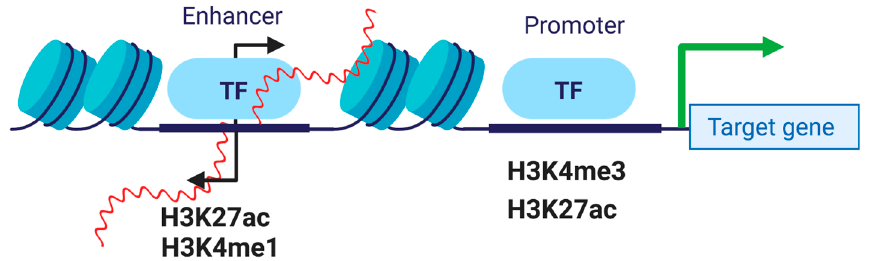
Figure 2. eRNA transcription at enhancers. Pol II transcribes eRNAs from active enhancers marked with H3K4me1 and H3K27ac.